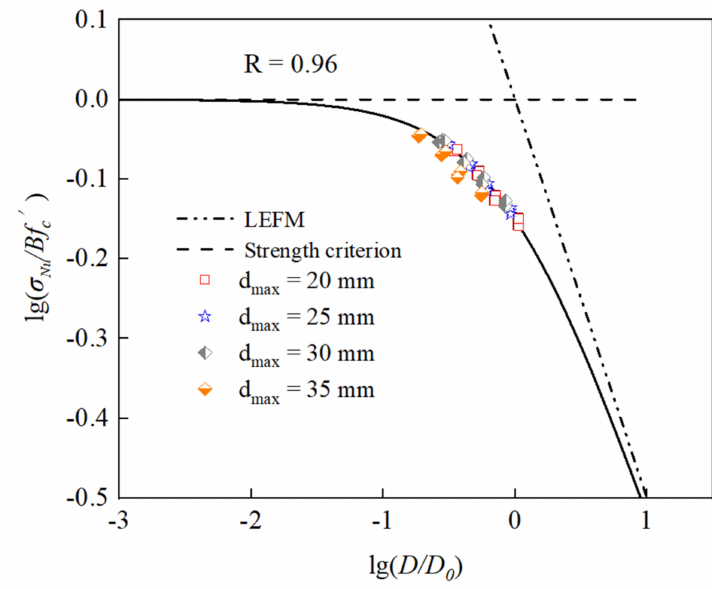
Figure 24. Verification of Bažant’s size effect law for